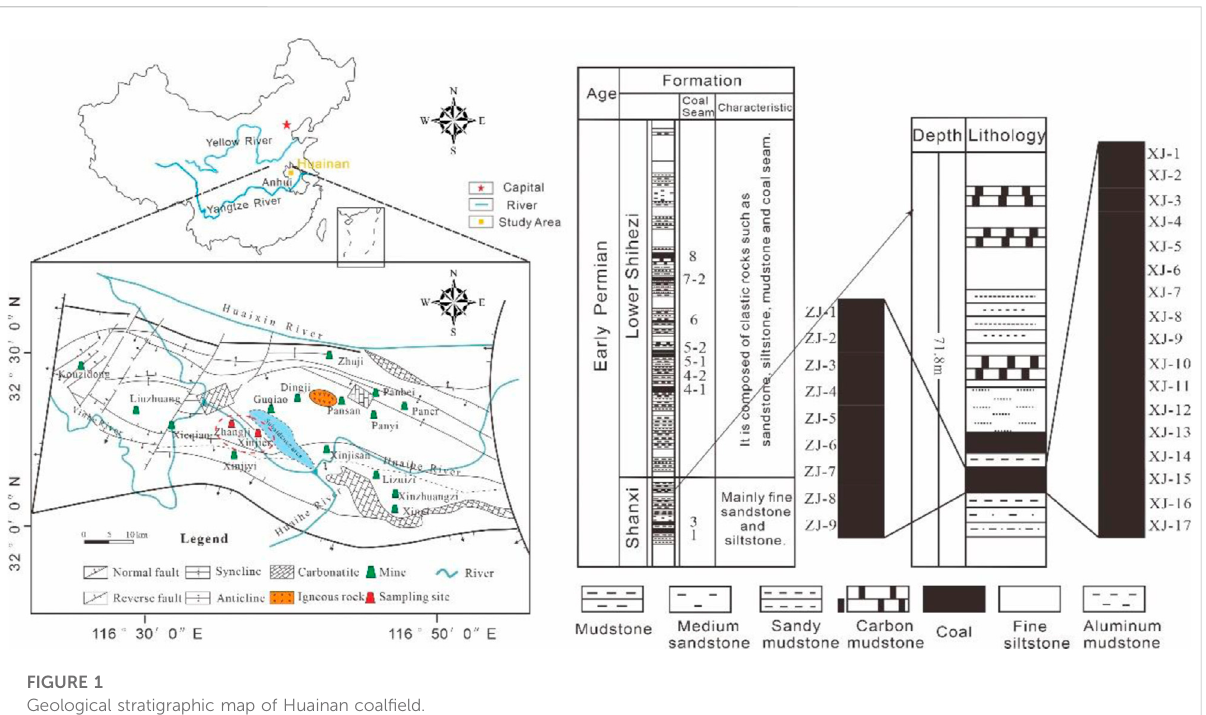
FIGURE 1 Geological stratigraphic map of Huainan coal fi